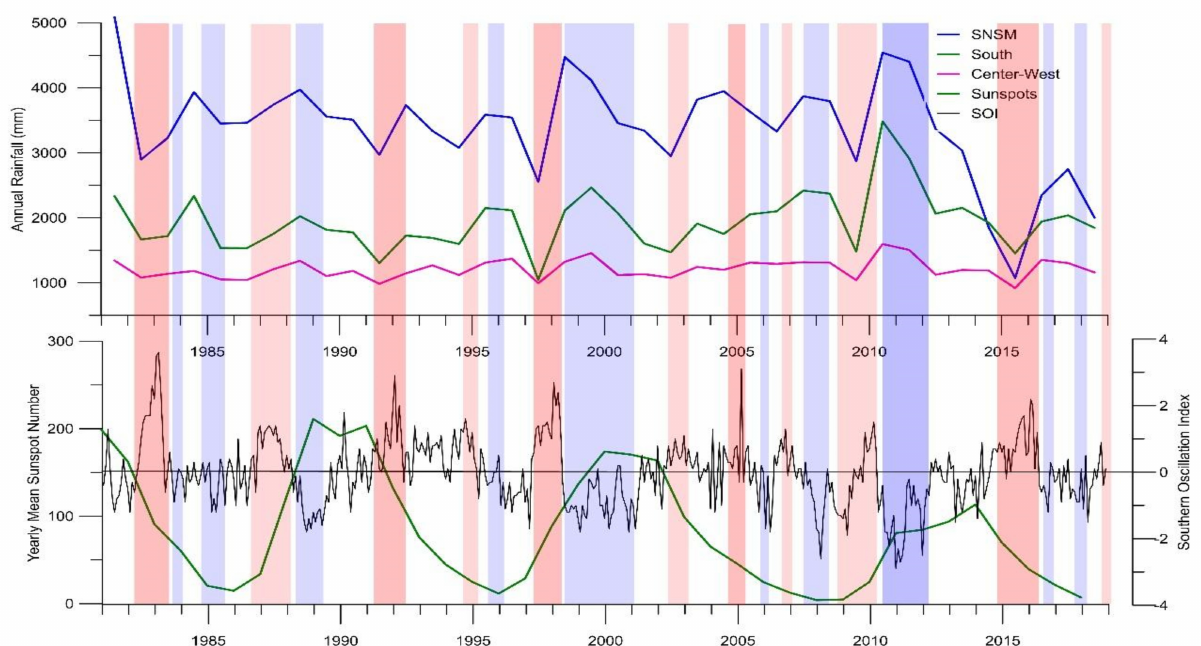
Figure 9. Top: total annual precipitation in the north (SNSM), south, and central-west zones in the Magdalena Department. Bottom: annual average of the sunspots total number (SILSO data/image, Royal Observatory of Belgium, Brussels) and South Oscillation Index (opposite sign, www.ncdc.noaa.gov/teleconnections/enso/indicators/soi/, accessed on 12 March